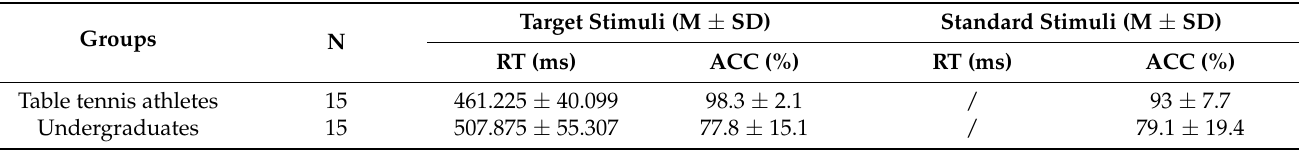
Table 1. Behavioral results for target stimuli and standard stimuli: reaction time and accuracy rate of both table tennis athletes and undergraduates.